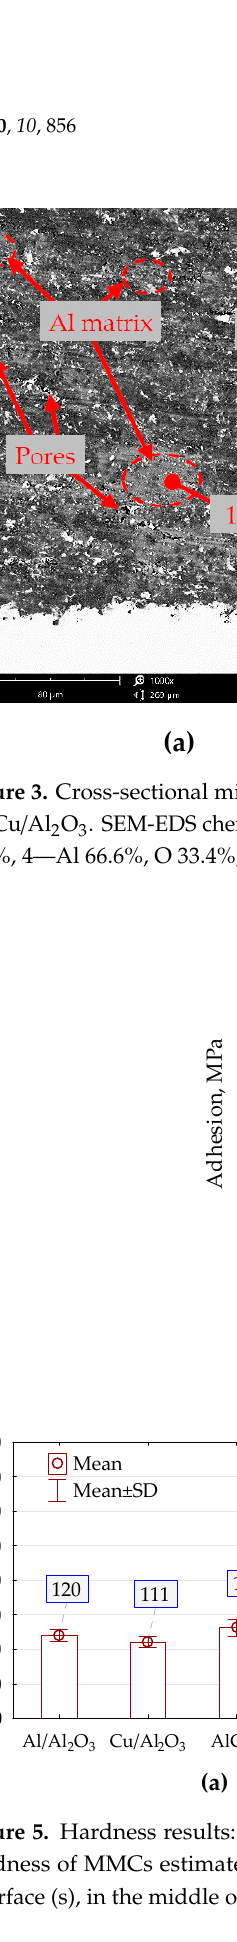
Figure 5. Hardness results: ( a ) Hardness of metal alloys and MMCs measured on their surface ( b ) hardness of MMCs estimated in their cross-sections: In the area located near the coating-substrate interface (s), in the middle of the coating thickness (m) and in the vicinity of the coating top (t).